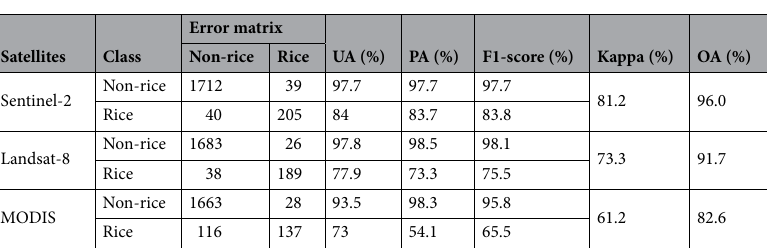
Table 2. Error matrix of paddy rice classification for three satellite data ( UA user’s accuracy, PA producer’s accuracy, OA overall accuracy).